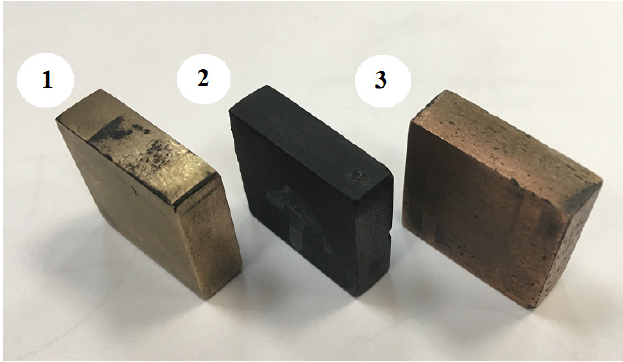
Figure 4. Electrode tools: 1—copper, 2—graphite, 3—composite. For tensile and low-cycle fatigue tests, ring-shaped electrode tools were used (Figure 5).